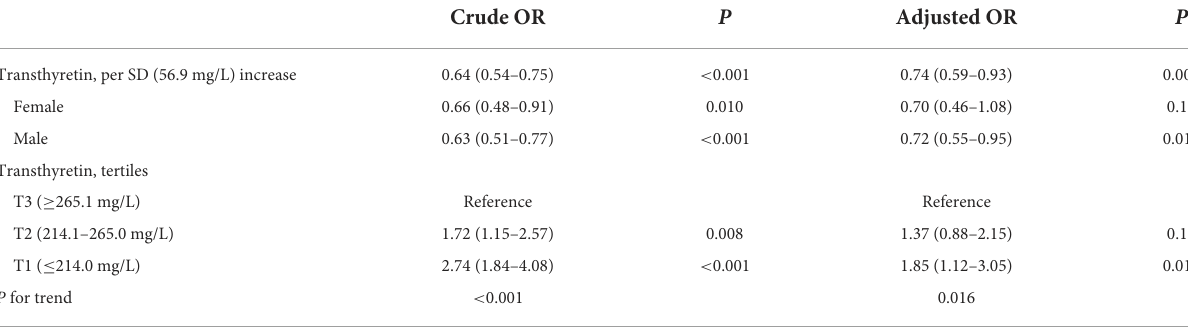
TABLE 3 Multiple logistic regression analysis to identify relationships between transthyretin and ICAS. Crude OR